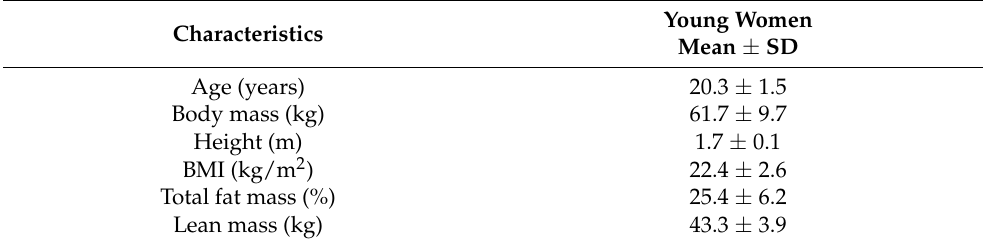
Table 1. General characteristics of participants ( n =